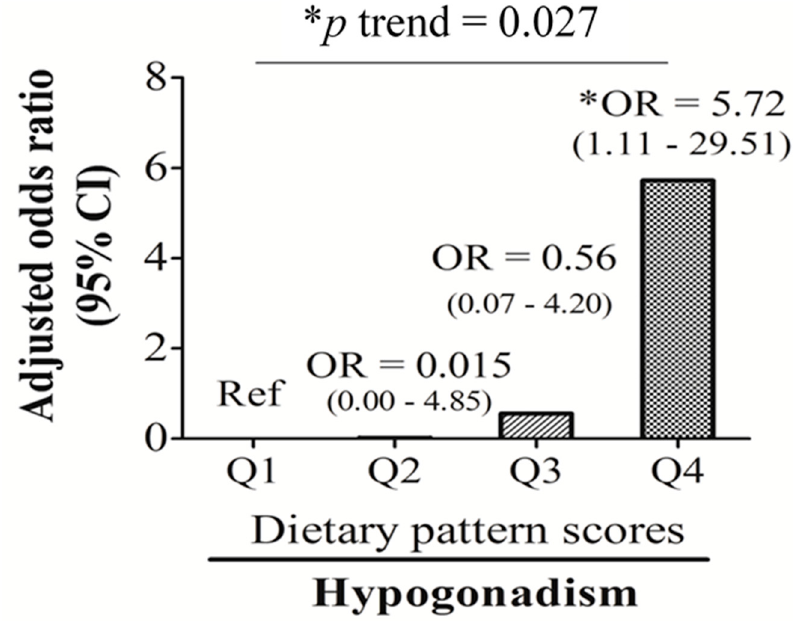
Figure 2. Odds ratios (ORs) and 95% confidence intervals (CIs) of dietary pattern score quartile levels for hypogonadism adjusted by age and log-transformed body-mass index. * p ≤ 0.05.